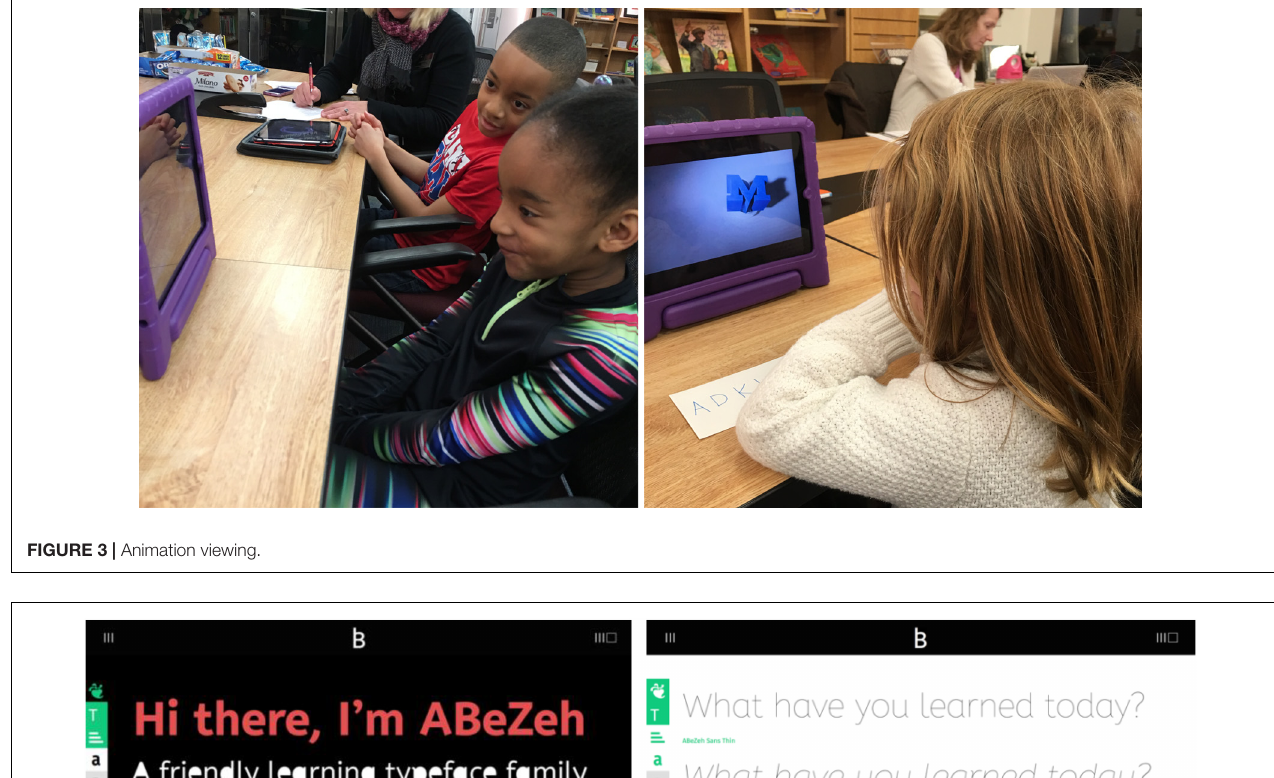
FIGURE 4 | ABeZeh type specimen (bBox, 2018).